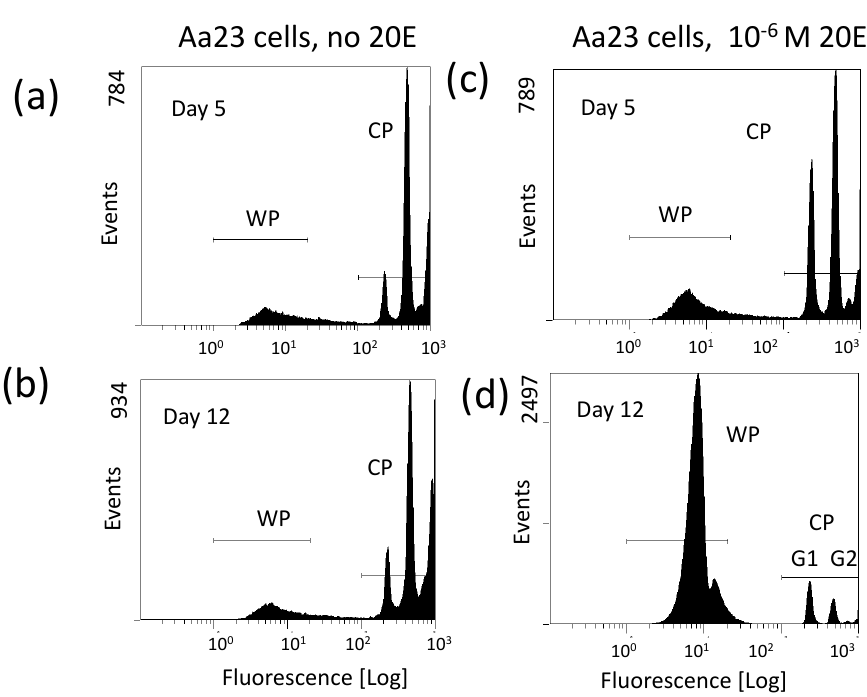
Figure 2. Ecdysone increases Wolbachia abundance in Aa23 cells. Panels ( a , b ) show profiles of Aa23 cells in the absence of ecdysone (20E) on day 5 and day 12 after plating cells at near confluence. Panels ( c , d ) show replicate plates with 2 × 10 − 6 M ecdysone added on day 0. Note that fluorescence corresponding to Wolbachia is represented by WP; fluorescence due to host cell nuclei is shifted to the far right (CP). Events on the Y-axis in panels ( a , c ) are similar, suggesting little effect of ecdysone during the first 5 days of exposure. On day 12, the WP has substantially increased in panel ( d ) relative to ( b ), reflecting improved yield of Wolbachia , and the CP has dropped, reflecting the negative effect of ecdysone on cell proliferation over time. Note that the CP profile in ( d ) shows a higher proportion of cells in G1 than in G2, as is the case with C7-10 cells [35]. This experiment was replicated with three independent biological samples.